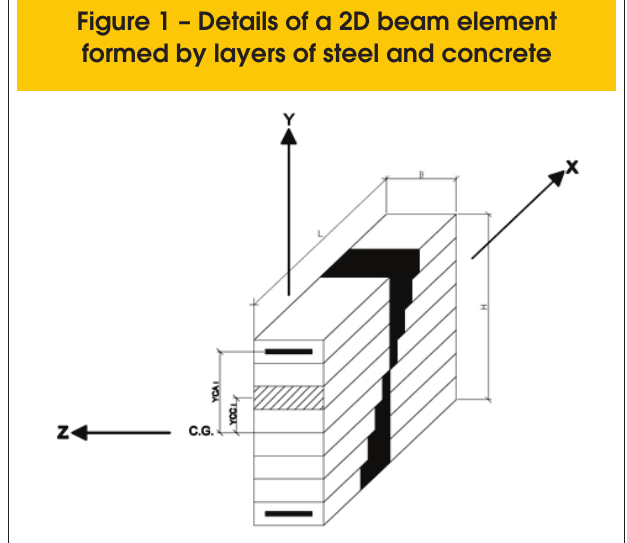
Figure 1 – Details of a 2D beam element formed by layers of steel and